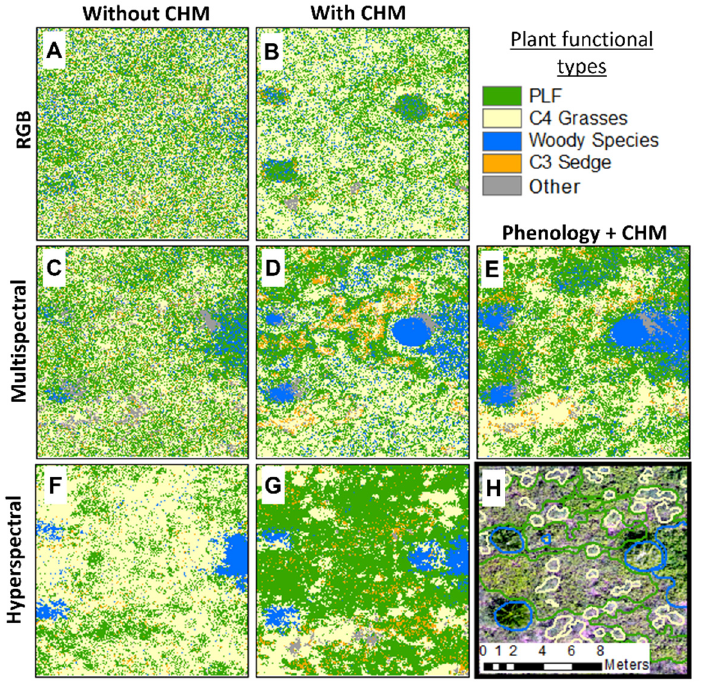
Figure 7. Example of random forest plant functional type (PFT) maps. Panels represent RGB ( A ), RGB + CHM ( B ), Multispectral ( C ), Multispectral + CHM ( D ), Multispectral + CHM + Phenology ( E ), Hyperspectral ( F ), and Hyperspectral + CHM ( G ) orthorectified UAS RGB imagery superimposed by ground-delineated reference data by PFT ( H ). See Supplementary Material (Tables S2, S4, S6, S8, S10, S12 and S14) for PFT summaries of the entire study area derived from our top-performing UAS network.